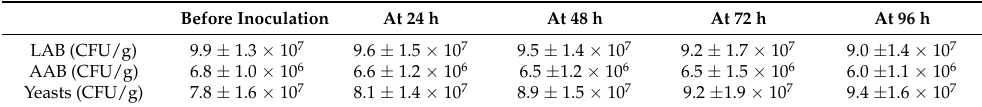
Table 2. Counts of Lactic Acid Bacteria (LAB), Acetic Acid Bacteria (AAB) and Yeasts in the Kefir Grains before Inoculation (t = 0 h) and after 24, 48, 72 and 96 h. Results Are Shown as Means ± Standard Deviations of Two Experiments and Three Analytical Replications